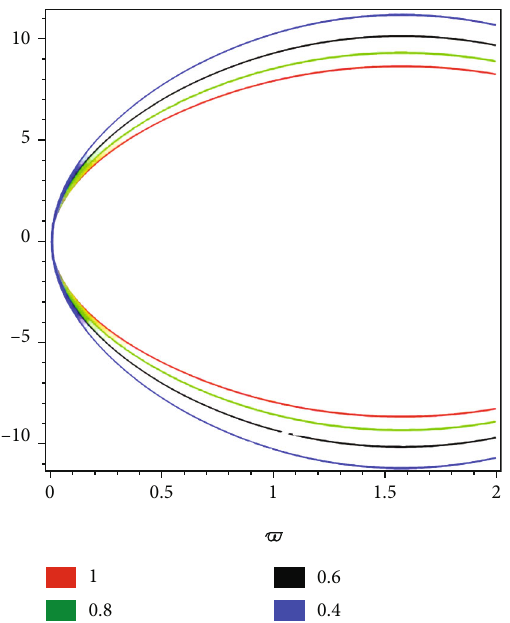
Figure 3: The upper and lower fuzzy two-dimensional di ff erent fractional-order solution graph of ϱ